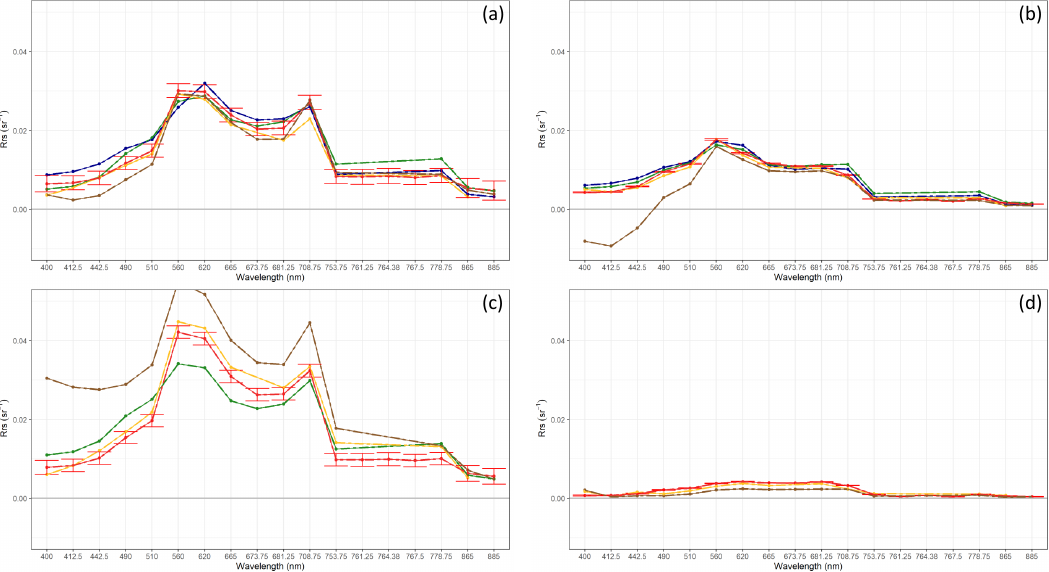
Figure 6. Comparison of all AC processors at four selected match-up station: ( a ) ID833, ( b ) ID786, ( c ) ID835 and ( d ) ID 2288 (in Table A2). Red denotes in situ measurements and corresponding uncertainty at every